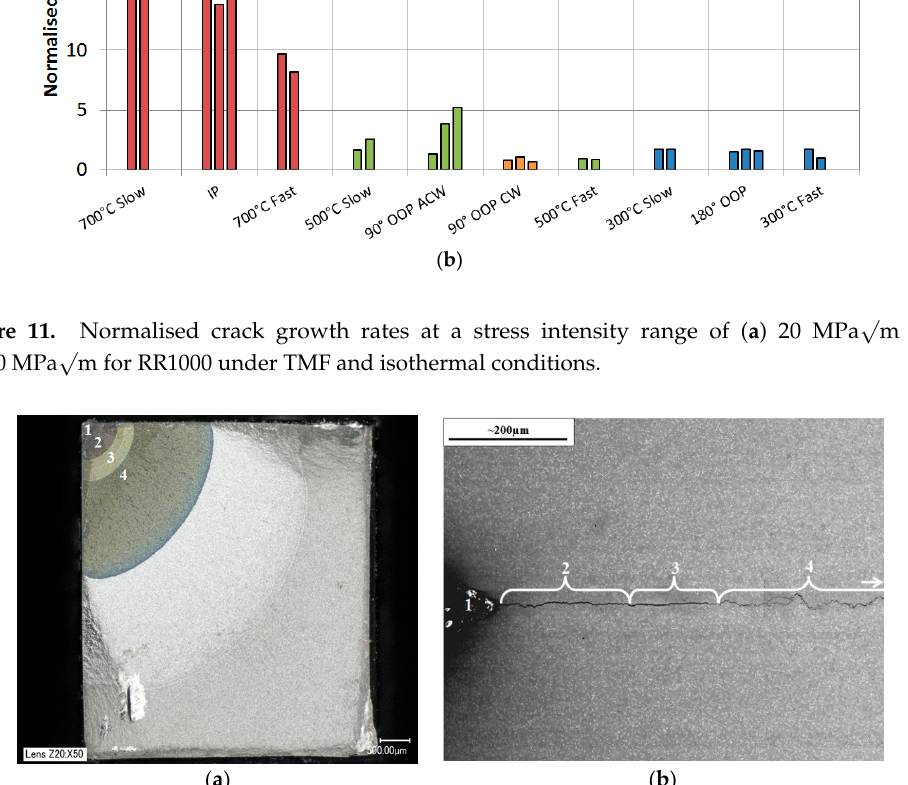
Figure 12. Notch, pre-cracking and test recognition from the two types of post-test analysis, ( a ) specimen stressed to failure and ( b ) unloaded for sectioning.